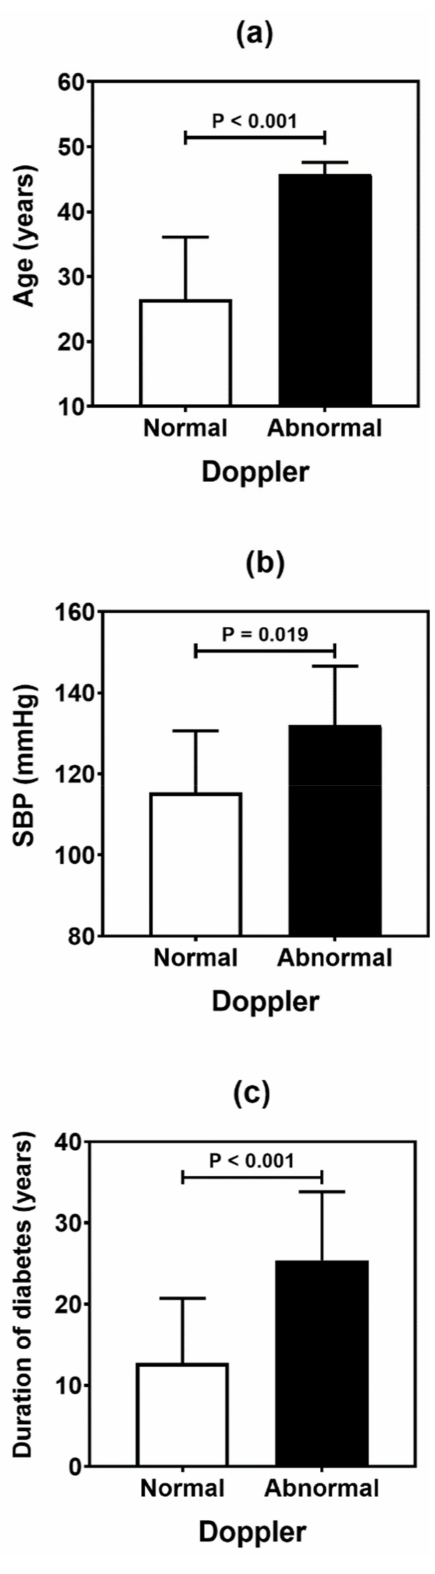
Figure 3. Comparative analysis (mean and standard deviation) of age ( a ), systolic blood pressure (SBP) ( b ), and duration of diabetes ( c ) in type 1 diabetes patients according to the carotid Doppler sonography. p values were determined by independent t